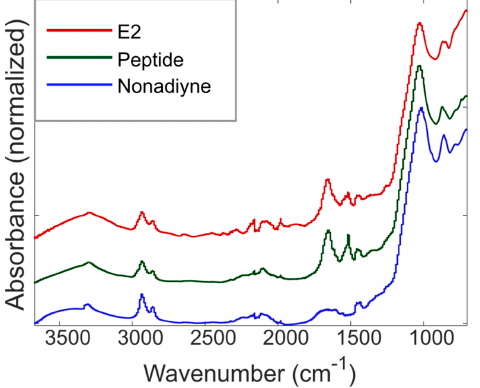
Figure 4. Surface functionalization and ATR-FTIR absorbance spectra. ATR-FTIR spectra confirming the attachment of the desired materials as described in the main text. A sharp peak near 3320 cm − 1 and a weak peak at 2100–2140 cm − 1 indicate the presence of alkyne groups associated with the nonadiyne. Furthermore, strong peaks at 2860 and 2930 cm − 1 corresponding to C-H stretching and a weak peak at 1668–1687 cm − 1 indicating C=C stretching are observed. Upon click reaction with the azide-modified peptide, the peak near 3320 cm − 1 reduces in intensity, indicating partial reaction of the alkyne groups to attach the peptide capture agent by a 1,2,3-triazole. Amide I and amide II bands are also observed near 1650 and 1520 cm − 1 , respectively, confirming the presence of attached peptide molecules. After capture of the E2 protein, the spectra include peaks associated with amino acids in the peptide and E2 protein.